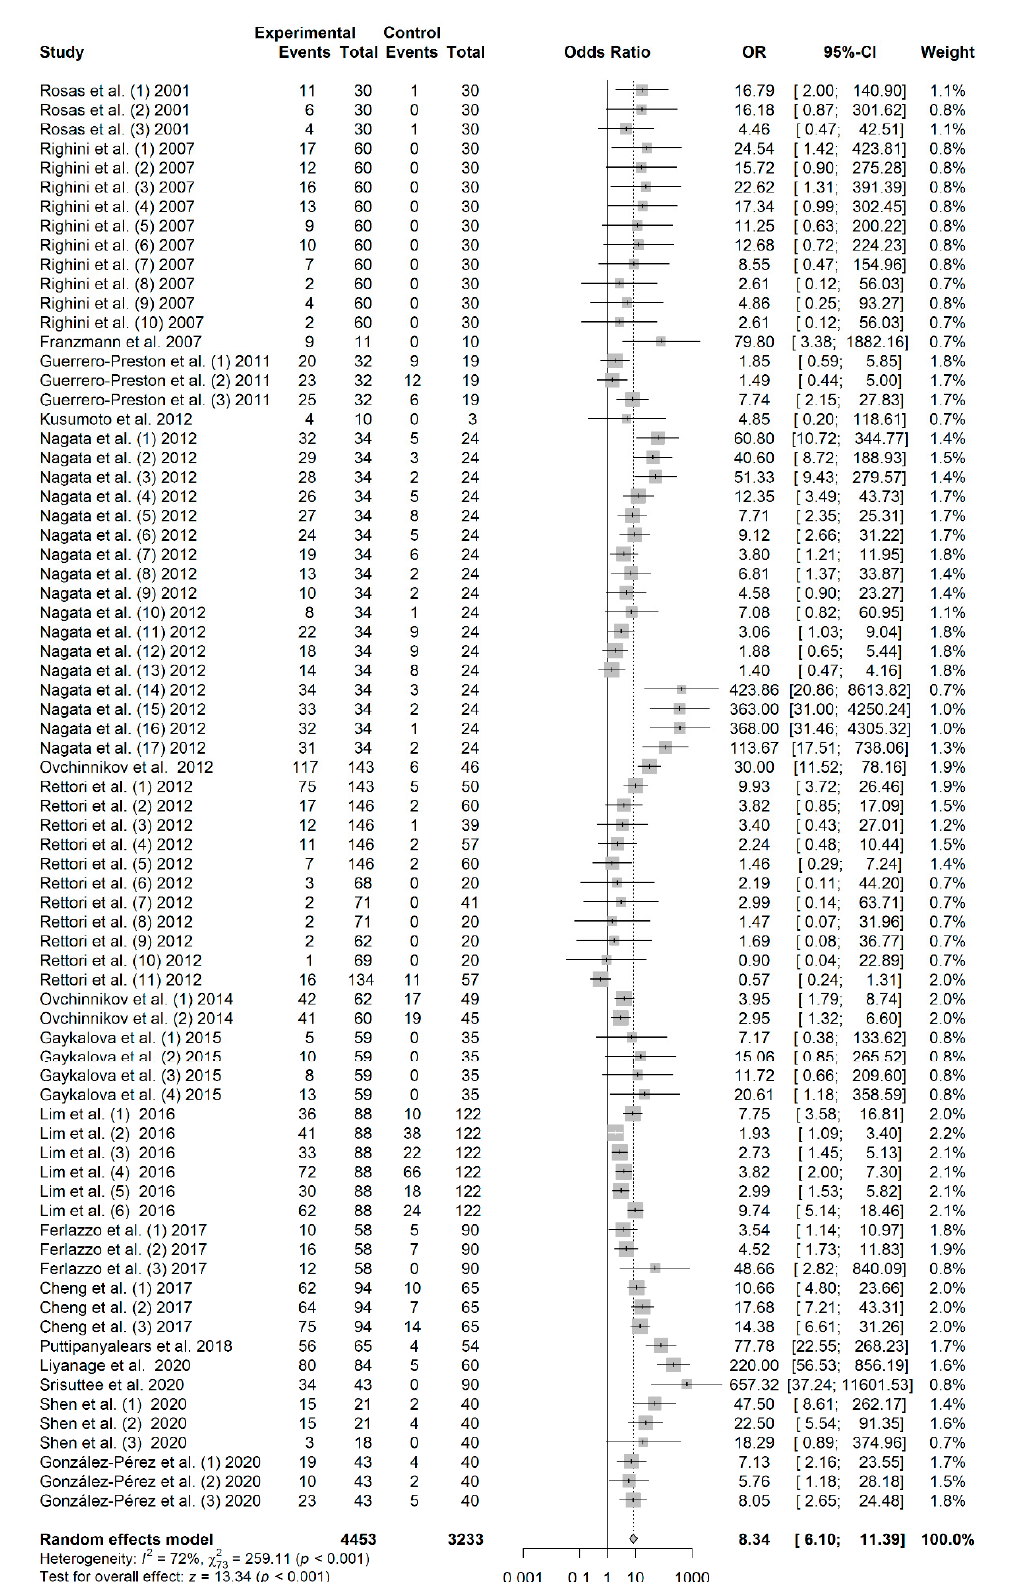
Figure 1. Forest plot for the association between salivary DNA promoter hypermethylation and the HNC risk. The squares represent the ORs for individual studies. Bars represent the 95% CIs. The center of the diamond represents the summary effect size.